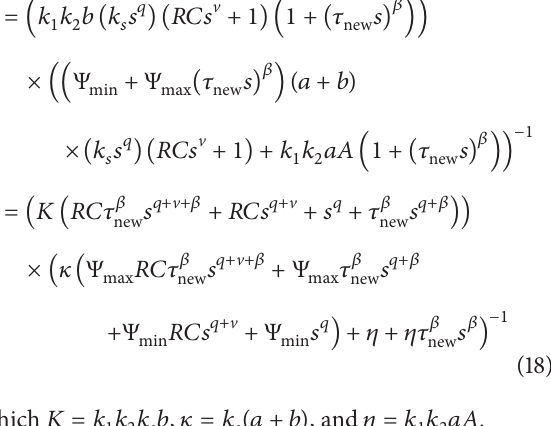
Figure 4: Pneumatic controller with a restriction in the feedback